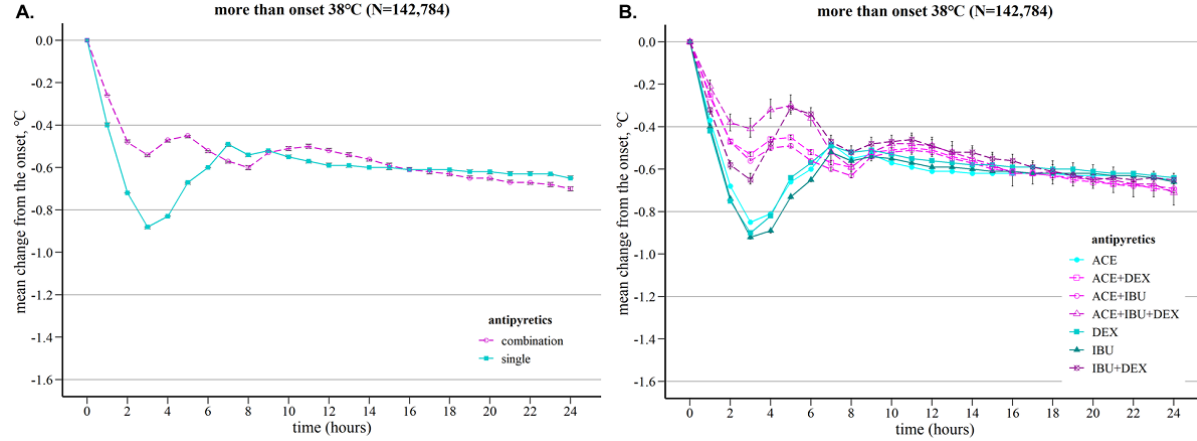
Figure 3. Average temperature changes according to the antipyretic administration pattern for 24 hours in cases where the temperature at the time of antipyretic administration was >38 ℃ : (A) comparison of the single and combination groups and (B) comparison of the type of antipyretic agent